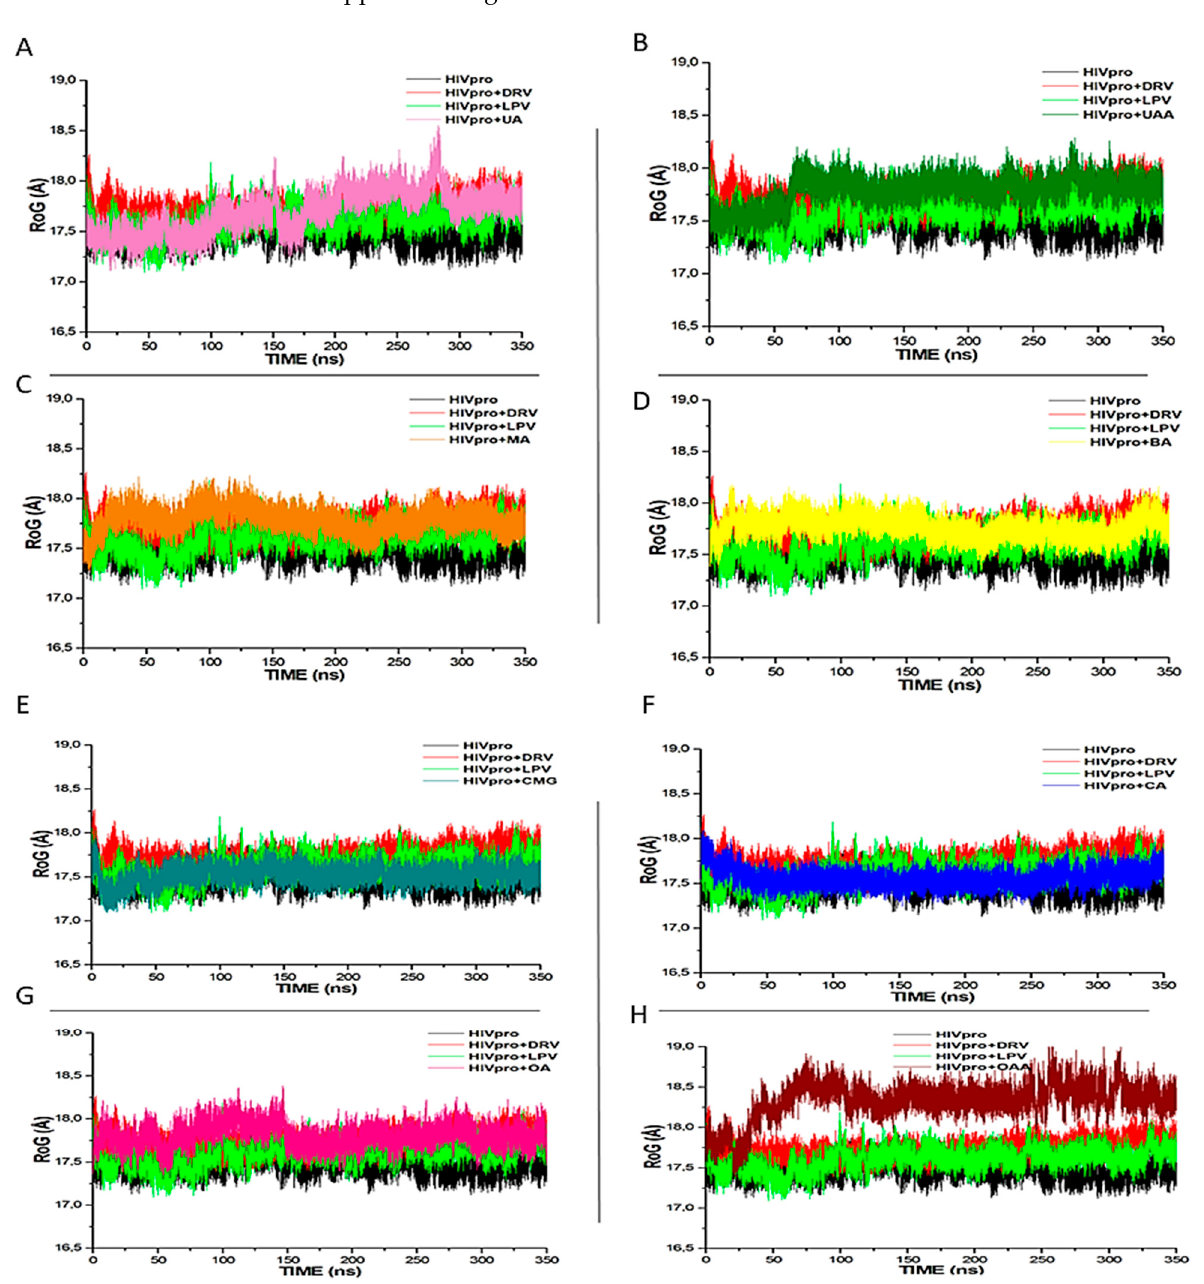
Figure 3. RoG profiles of protein backbone atoms of HIVpro, with LPV, DRV, and ( A ) UA, ( B ) UAA, ( C ) BA, ( D ) MA, ( E ) CMG, ( F ) CA, ( G ) OA, and ( H ) OAA systems over a 350 ns molecular dynamics simulation period.